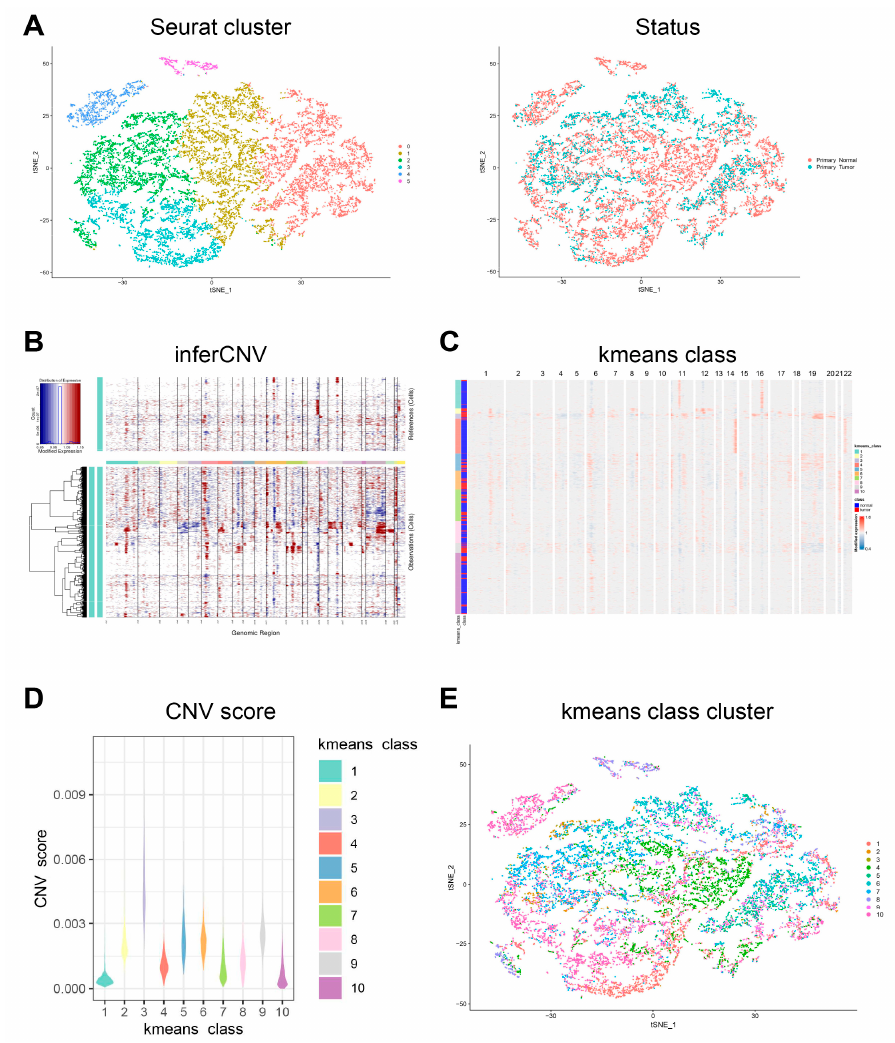
Figure 3. Copy-number variation analysis of epithelial cells. ( A ) tSNE plots showing the Seurat cluster and status of epithelial cells. ( B ) Hierarchical heatmap showing large-scale CNVs in the epithelial cells of a primary tumor and in normal tissues. ( C ) Hierarchical heatmap showing the results of k-means class clustering. ( D ) Violin plots showing CNV scores in the different k-means classes. ( E ) tSNE plot showing the epithelial cells in the different k-means class